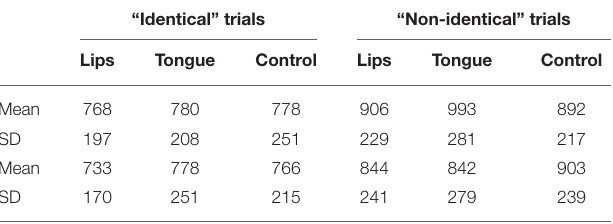
TABLE 1 | The effect of stimulation on response time. “Identical” trials “Non-identical”